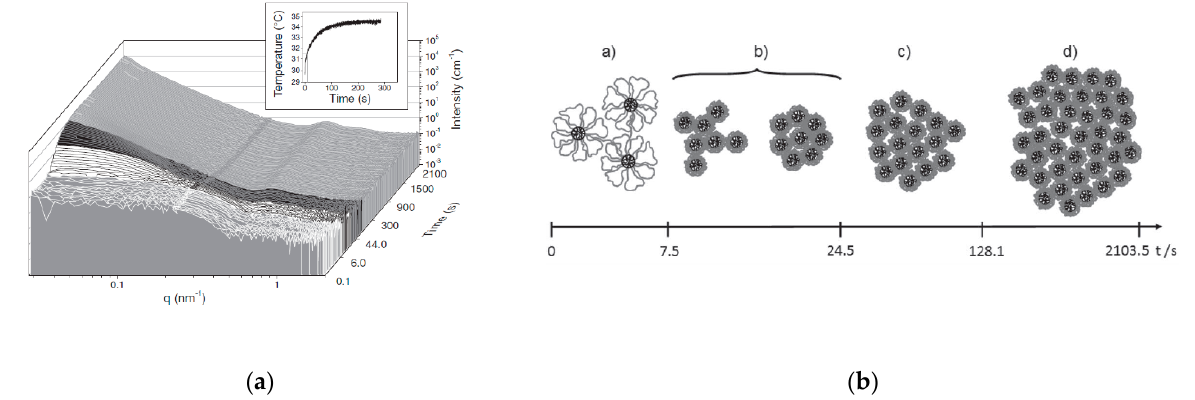
Figure 3. ( a ) Left hand panel, SANS curves obtained during a temperature jump on a micellar solution of P(S-b-NIPAM-b-S), from 29 to 35 °C, where the first structural changes were observed 7 s after initiation of the experiment. ( b ) The right-hand panel shows the structural models determined from the data, where micelles collapse and subsequently aggregate into clusters (reproduced with permission from [28], Wiley, 2012).